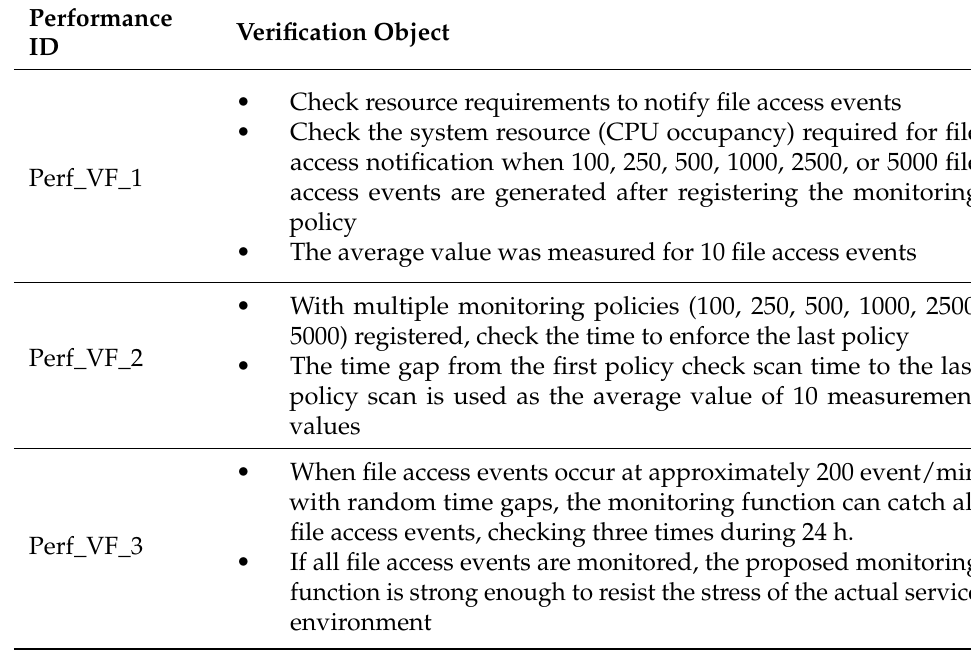
Table 4. Performance verification items.